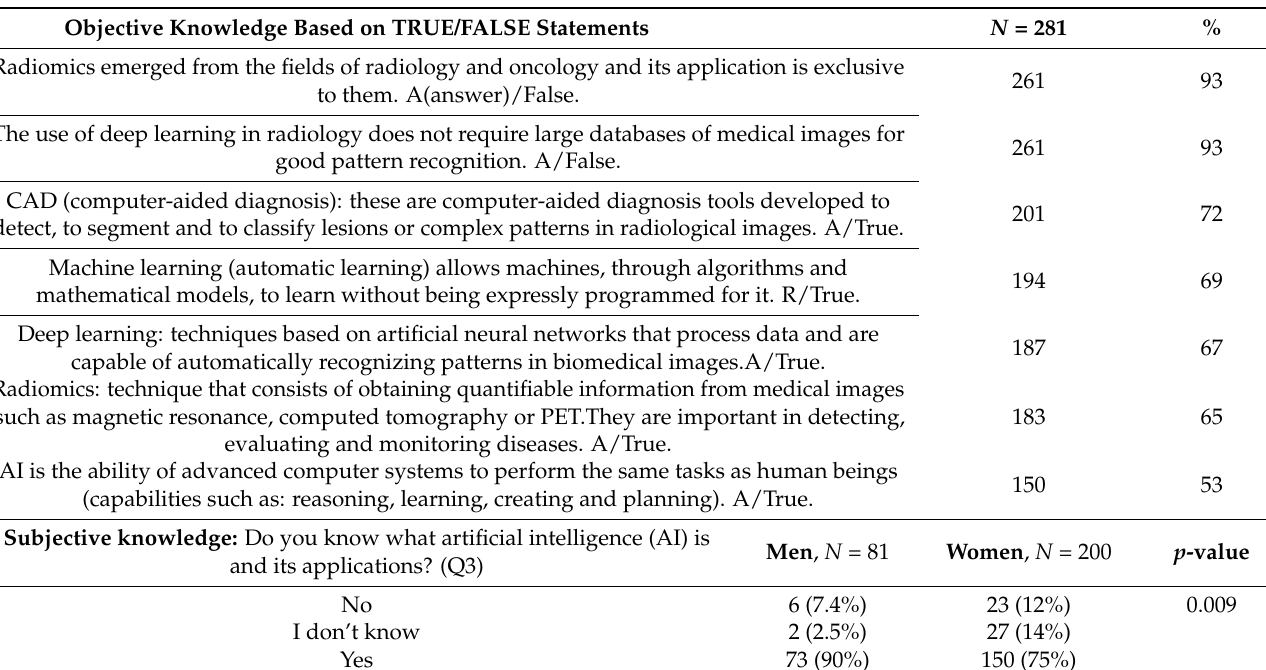
Table 2. Subjective and objective assessment of the students’ AI